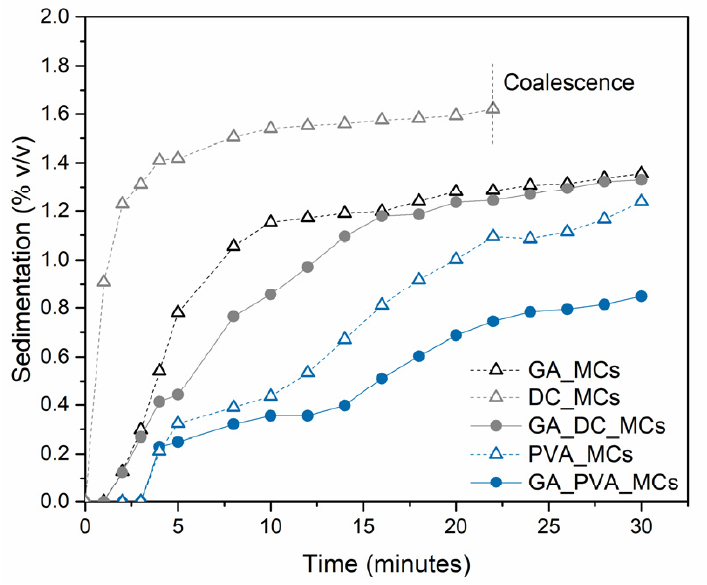
Figure 3. Evolution of the sedimentation volume fraction over time, of all the reported emulsions in study, while at rest (static conditions).